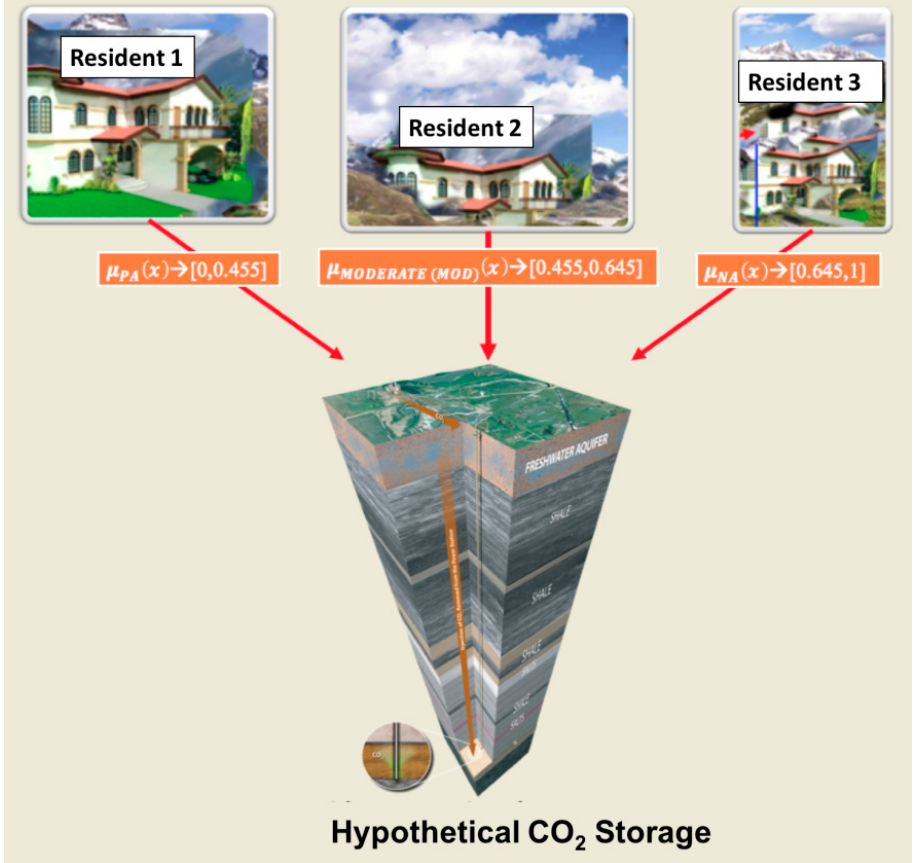
Figure 5. The affective framework with which Agent 2 makes its prediction. PA indicates positive affective feelings; NA indicates negative affective feelings and MOD indicates moderate feelings. These affective clusters are positive affective feelings (PA), moderate affective feelings (MOD) and negative affective feelings (NA). Using the CO 2 storage example as shown in Table 1, PA indicates positive affective feelings toward the CO 2 storage. NA indicates negative affective feelings. It is a prediction for those who have problems with the CO 2 storage being close to them and who are emotionally averse to its approval. Finally, MOD indicates moderate feelings. It is a prediction for those with indecisive feelings and struggling to take a position. Table 1. Structure of the data and how the agent is expected to react to a citizen and collect their qualitative information and communicate it to the project developers for appropriate intervention.